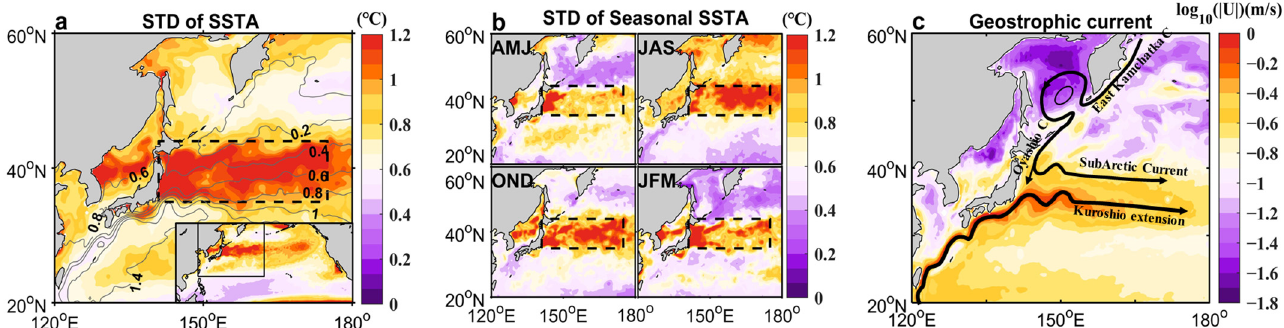
Figure 1. ( a ) Standard deviation of sea surface temperature anomalies (SSTA, shading) and mean sea surface height (gray lines) in the Northwest Pacific Ocean; ( b ) Standard deviation of SSTA in the boreal spring (AMJ), summer (JAS), autumn (OND), and winter (JFM); ( c ) Amplitude of annual mean geostrophic current velocity (shading) and sketches of main near-surface currents (black lines). SST anomalies are derived from NOAA OISST V2 with 0.25 ◦ × 0.25 ◦ resolution from 1982 to 2021, and sea surface height and geostrophic current data are from CMEMS with 0.25 ◦ × 0.25 ◦ resolution from 1993 to 2021. The area framed by the black dashed lines represent the KOE domain (141–175 ◦ E, 35–44 ◦ N), the inset of ( a ) shows the pattern of the North